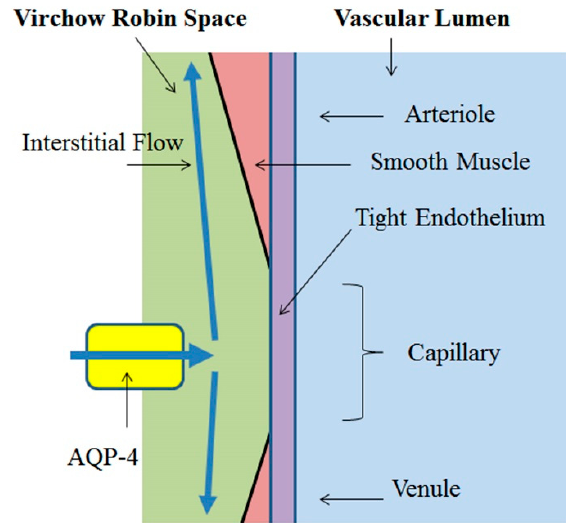
Figure 3. Peri-capillary VRS water dynamics. Brain capillary endothelial tight junctions and active suppression of AQP-1 expression highly restricts water movement across the BBB. By contrast, significant water flow (blue arrow) is present inside the BBB within VRS (interstitial flow), mediated by active water inflow through AQP-4. Modified from Reference [9].